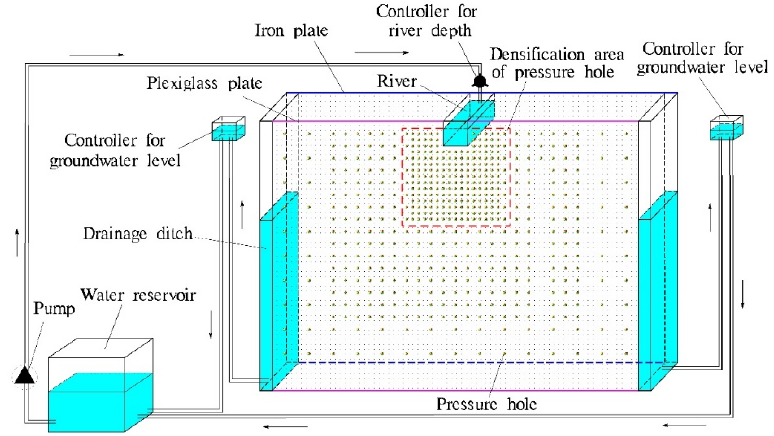
Figure 1. Schematic representation of the sandbox used in the